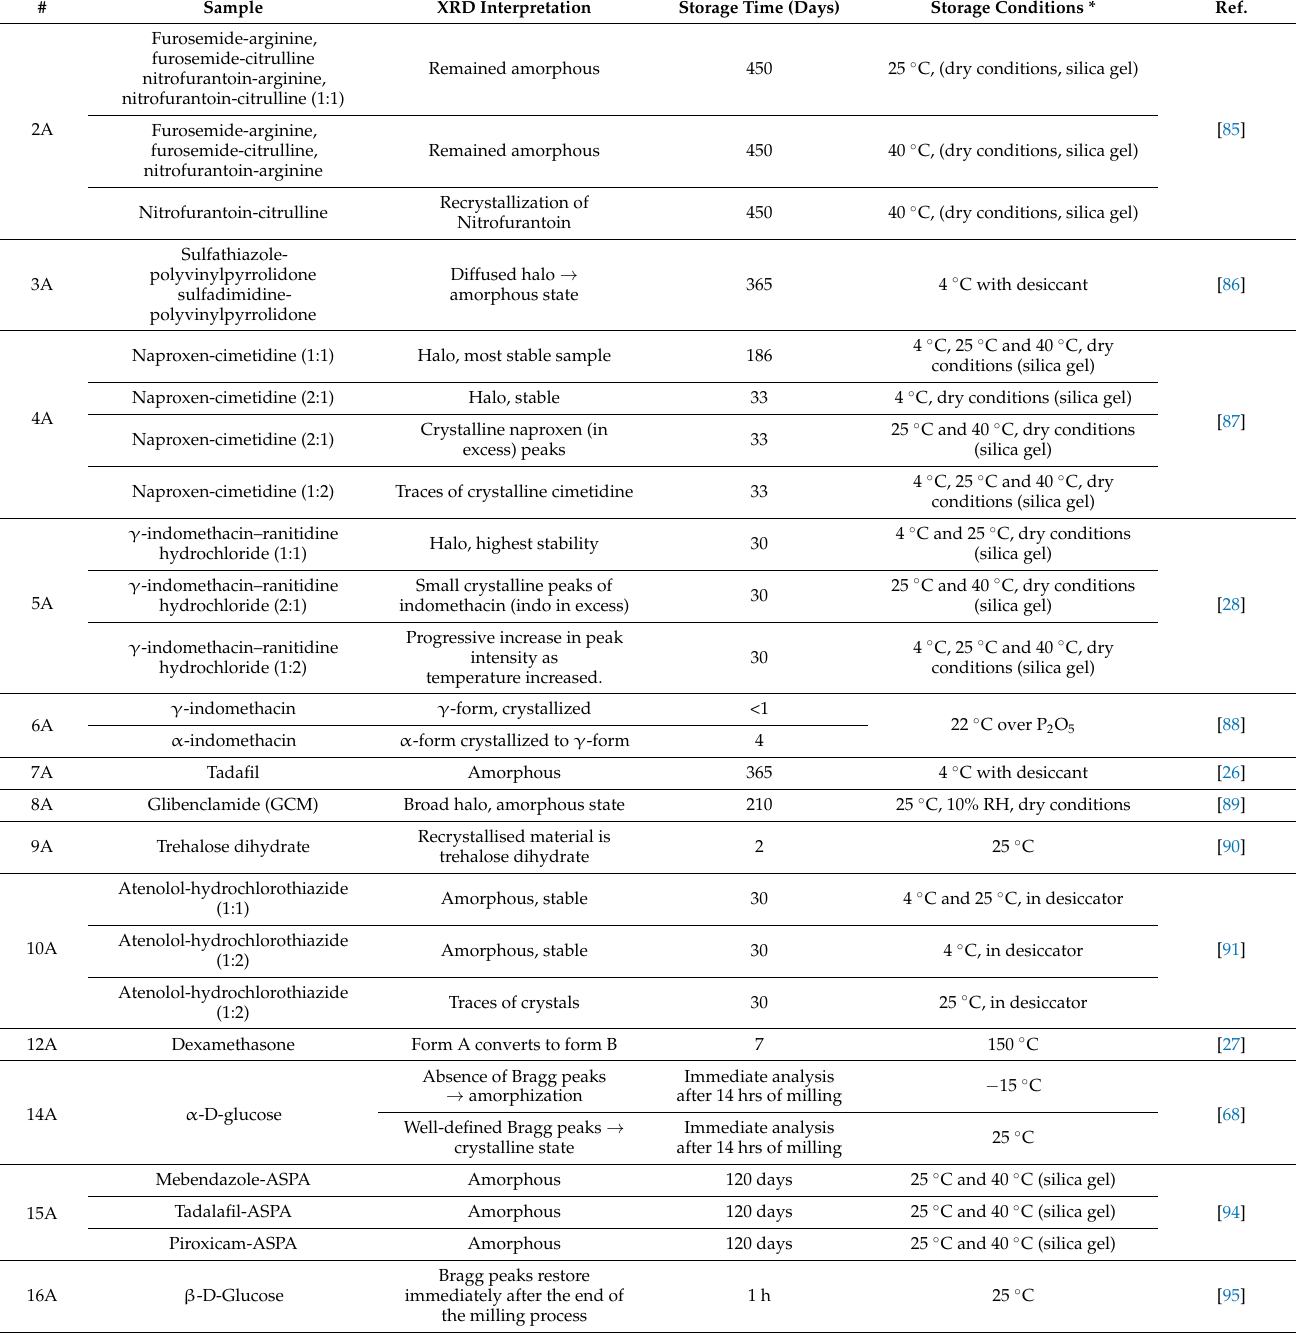
Table 14. Overview of structural stability of amorphous systems upon storage in diverse